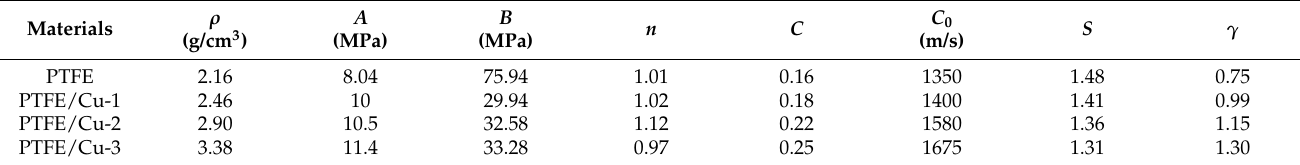
Table 3. Main material parameters of liners.